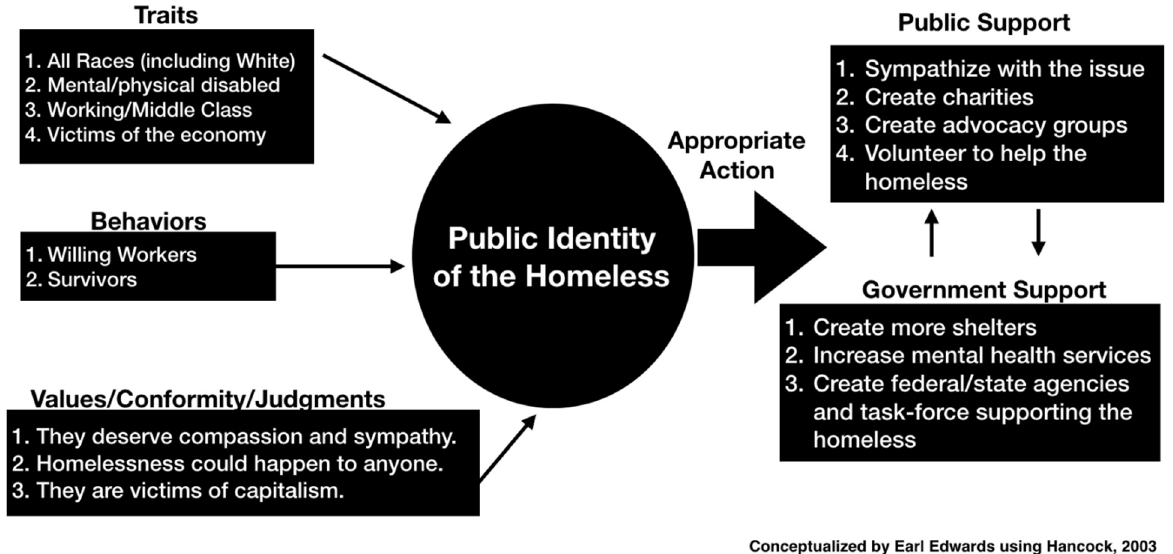
Figure 1. The everyday people public persona for the homeless.